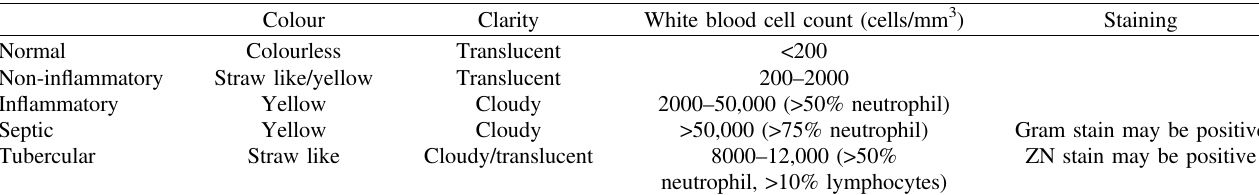
Table 1. Physical and cytological characteristics of synovial fl uid.